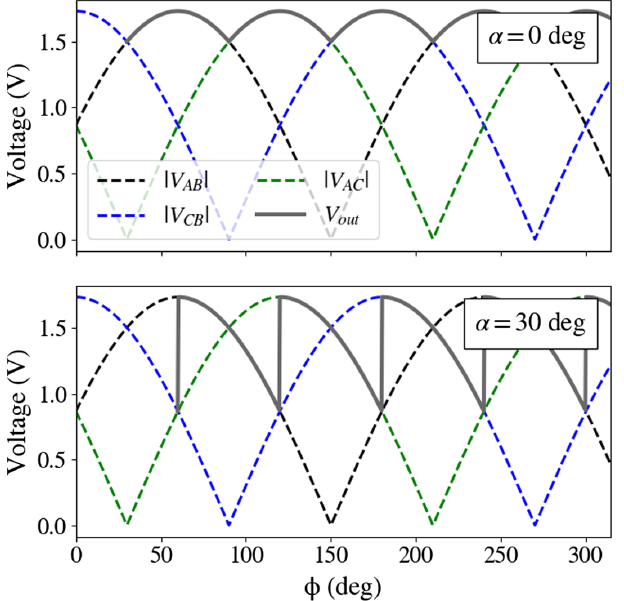
FIG. 24. The output voltage of the three pairs of conducting thyristors (black, blue and green) as a function of the phase. The gray line illustrates the output voltage due to the rectification process for a firing angle of α ¼ 0 (top) and α ¼ 30 degrees